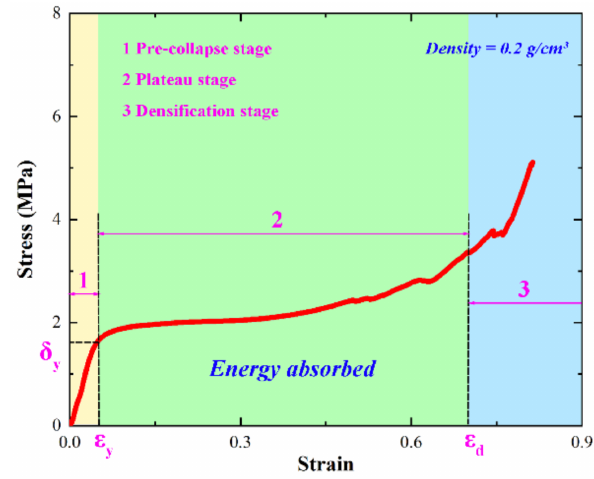
Figure 8. Representative stress–strain curve of PU specimen.